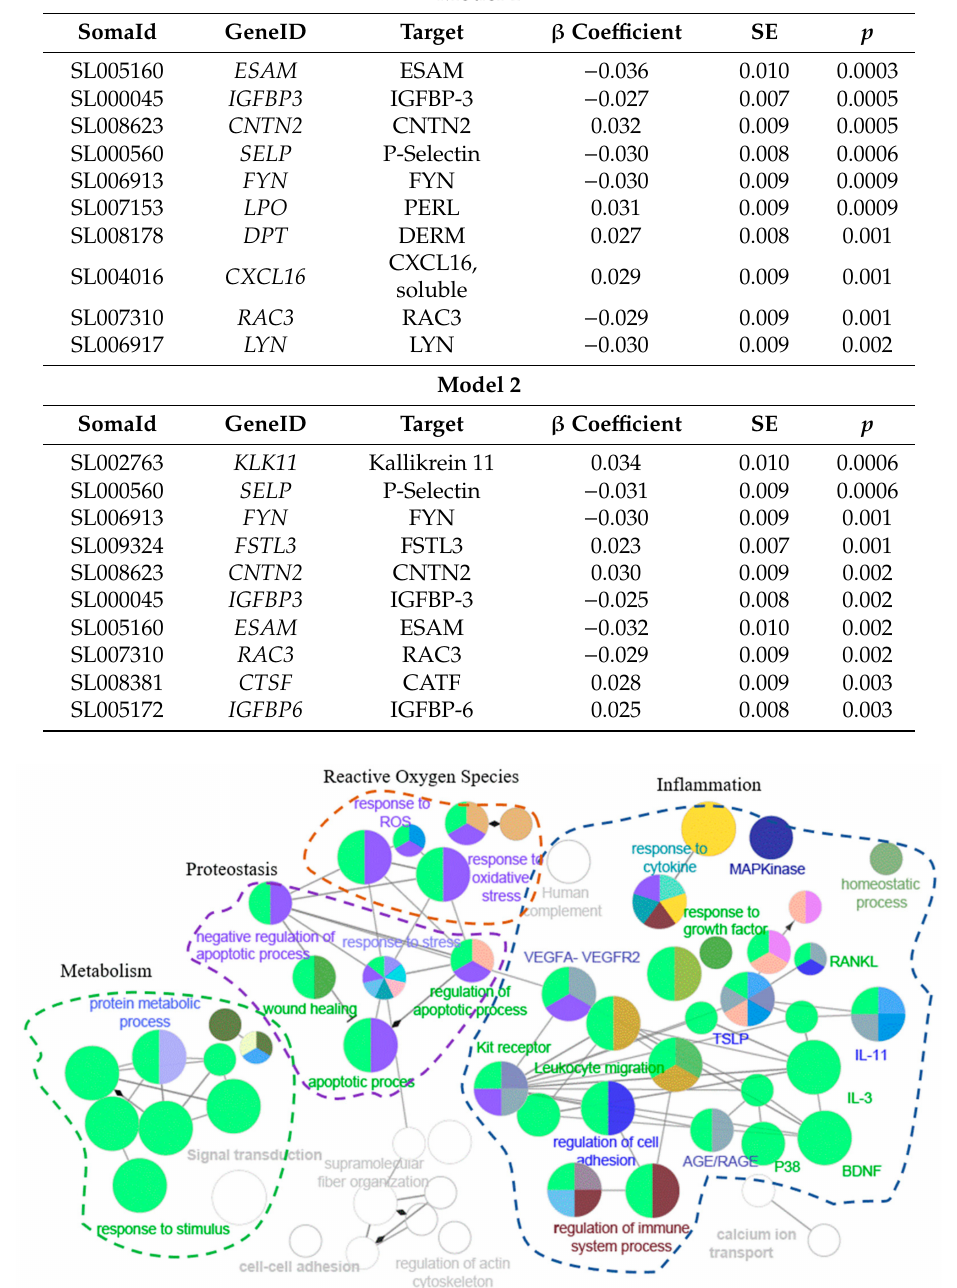
Figure 2. Network visualization of the 87 proteins associated with muscle oxidative capacity. Pathways are functionally grouped and interconnected by edges. Each node is a pathway, and the size of the node represents the significance of the pathway enrichment. The most biologically significant pathways for the purposes of our study are colored, and functionally similar pathways are